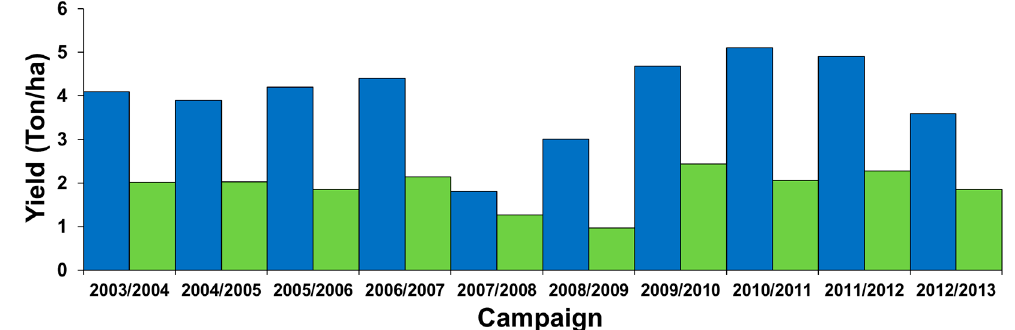
Figure 14. The Santa Catalina stream basin crops yields for the 2003–2013 period. Winter wheat (blue) and soybean (green).